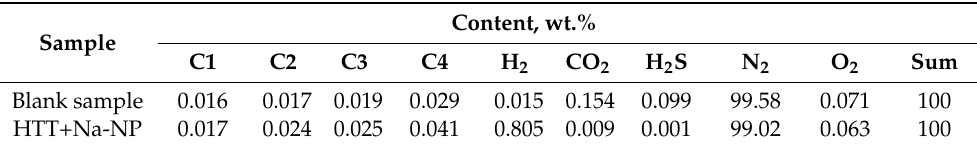
Table 1. The content of evolved gases after the aquathermolytic upgrading of heavy oil in the absence and presence of sodium